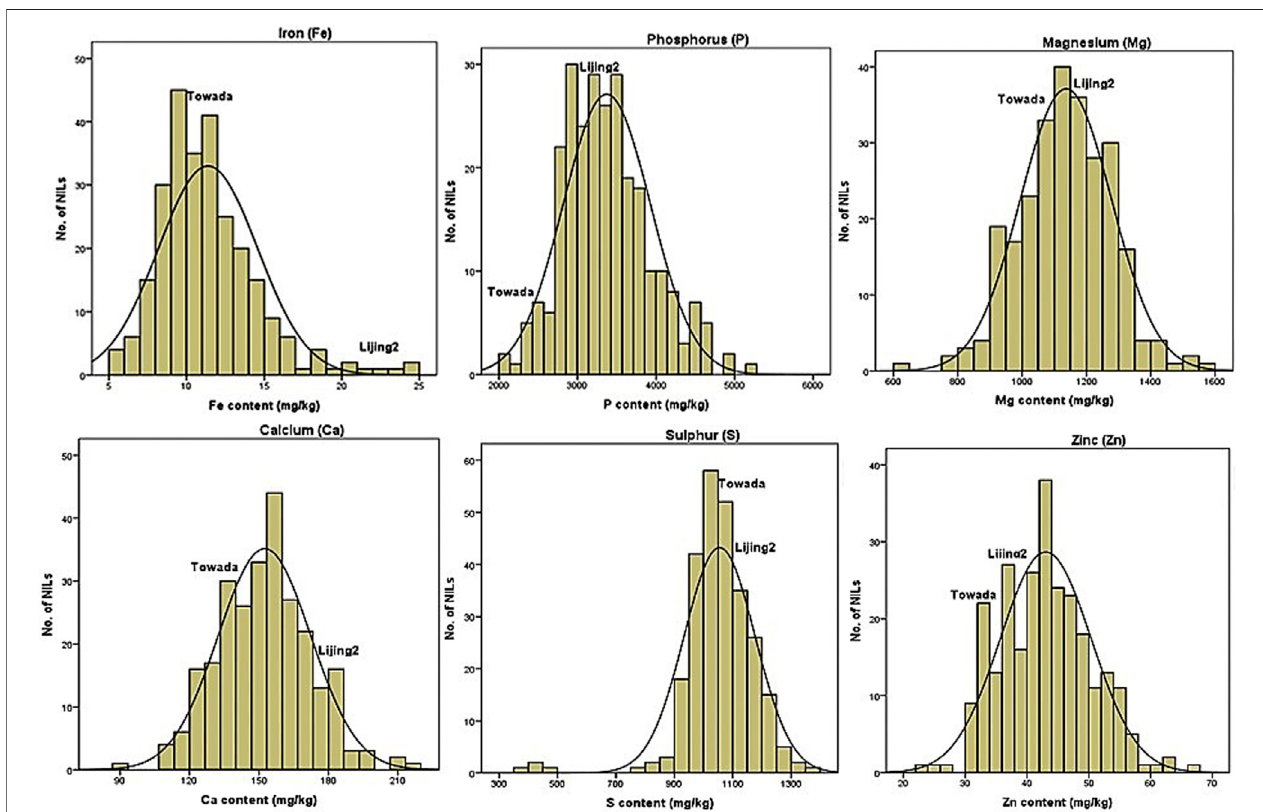
FIGURE 2 | Frequency distribution of some mineral (Fe, P, Mg, Ca, S, and Zn) elements quanti fi ed in NILs of Towada brown rice subjected to chilling stress at booting stage.